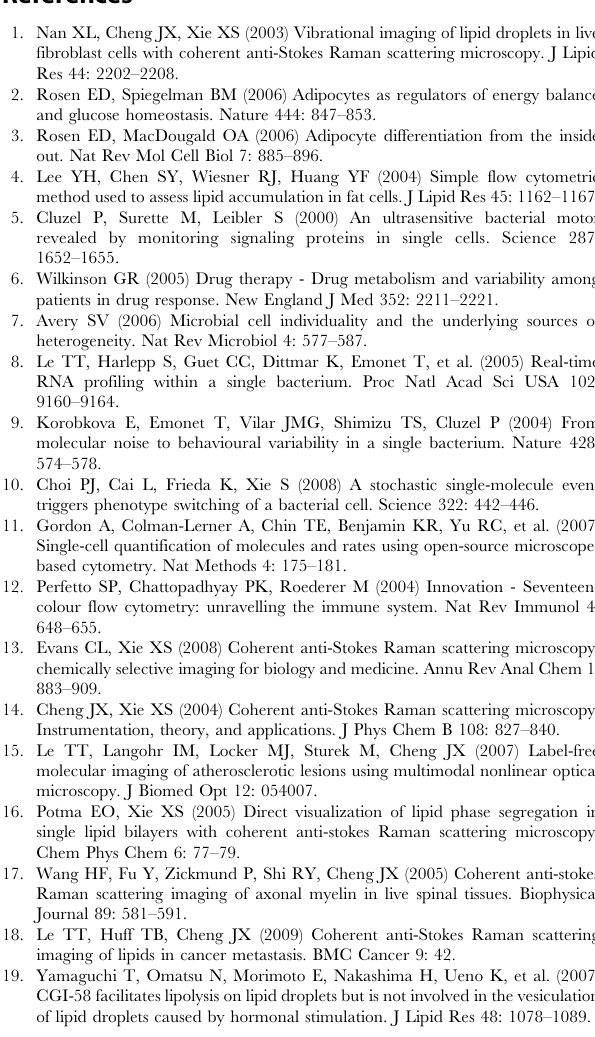
Figure S6 Lipid droplets formation as a function of PPAR c gene activity, insulin uptake, and glucose import. Y-axis reports single- cell flow cytometry analysis of lipid droplets formation, or side scatterings due to cytoplasmic granularity. X-axis reports fluores- cence intensity of dsGFP, insulin-Cy3, and glucose analog-FITC which reports PPAR c gene activity, insulin uptake, and glucose import, respectively. Cells are analyzed at day 8 after adipogenesis induction. Lipid-rich cells exhibit a lack of correlation between PPAR c gene activity and lipid droplet formation, but strong correlations between lipid droplet formation, insulin uptake, and glucose import. Found at: doi:10.1371/journal.pone.0005189.s006 (0.74 MB